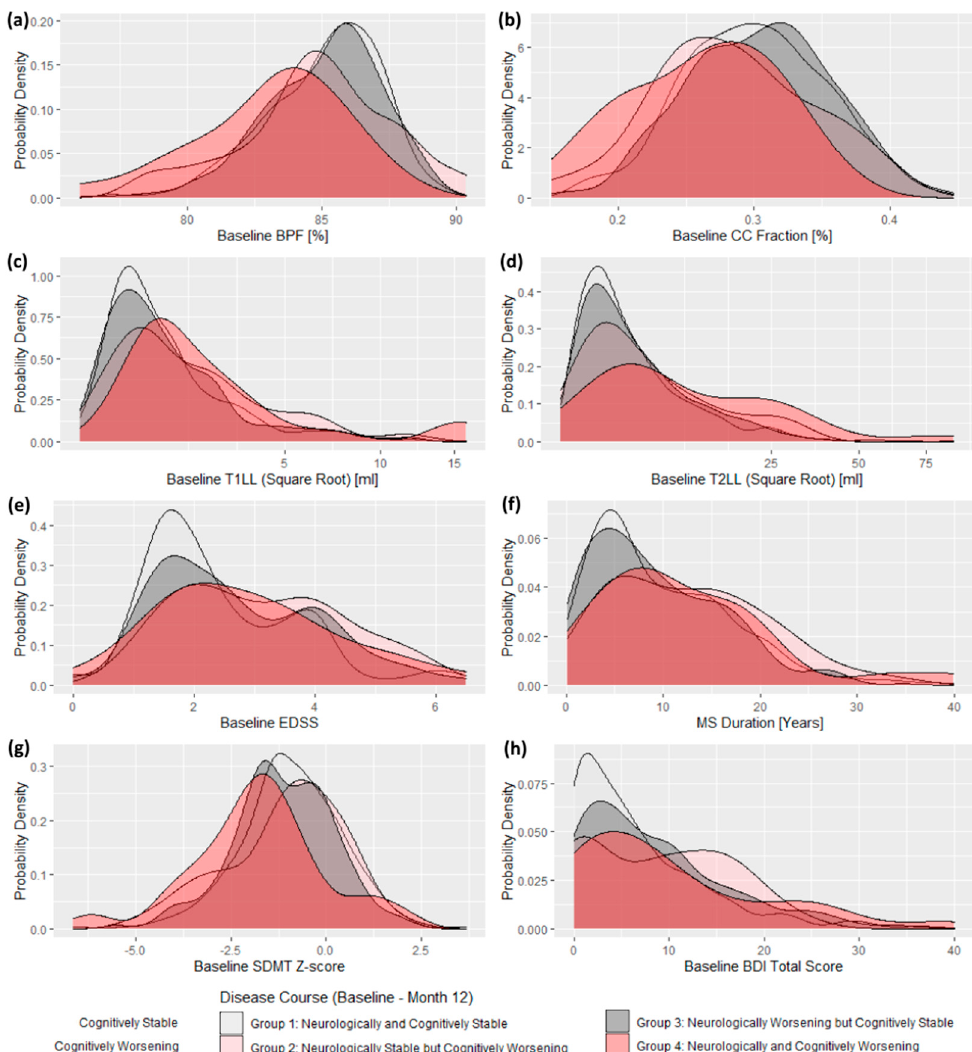
Figure 3. Between-group differences in baseline radiological ( a – d ), neurological ( e , f ), and neuropsychological ( g , h ) scores showed on probability density plots: example of the similar trend of worse baseline disease markers in both cognitively worsening groups (red), in a contrast to both cognitively stable groups (grey). (Legend: BPF = Brain parenchymal fraction, CC = Corpus callosum, T1LL = T1 Lesion Load, T2LL = T2 Lesion Load, EDSS = Expanded Disability Status Scale, SDMT = Symbol Digit Modalities Test, BDI = Beck Depression Inventory.)